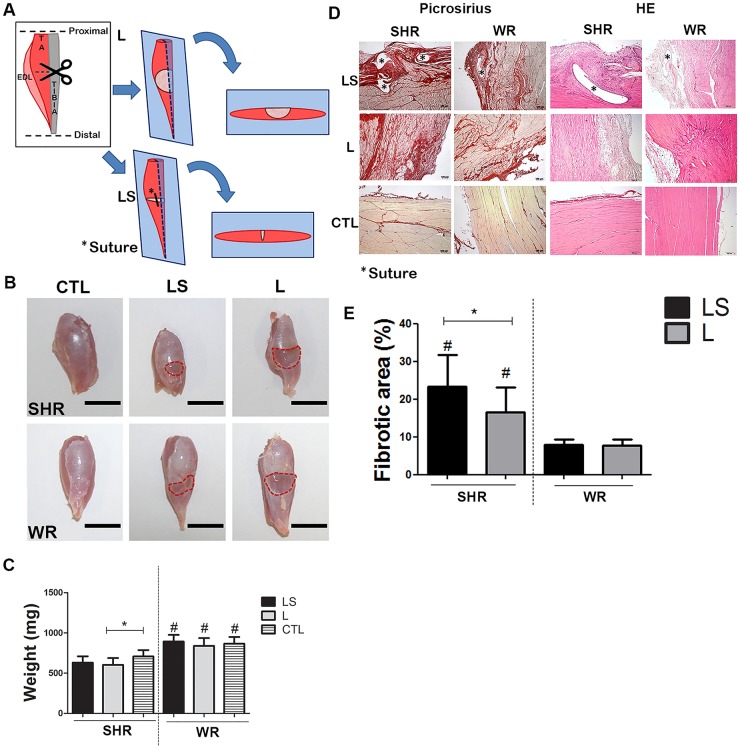
Rat muscle injury model.(A) Schematic design of the rat muscle injury model. The tibialis anterior (TA) muscle was cut in the middle (laceration group: L) and sutured (laceration-suture group: LS) or not. Four weeks after this procedure, the muscle was excised and cut longitudinally to histology. (B) Macroscopic images of the TA muscle from SHR and WR (scale bar = 1 cm). (C) TA muscle weight comparison among groups Representative micrographs of sections stained with PR or HE (scale bar = 50 μm). (D) Fibrotic areas quantified using images from Fig 1D (E). * indicates statistically significant differences (p<0.05) when animals of the same species of rats were compared with subjected to different laceration processes. # indicates statistically significant differences (p<0.05) when animals of different species were compared for subjected to the same laceration process. Values represent mean ± standard deviation. n = 5 rats per group. TA: tibialis anterior; EDL: extensor digitorum longus; SHR: spontaneously hypertensive rat; WR: Wistar rat; CTL: control group (without injury); PR: Picrosirius Red; HE: hematoxylin-eosin.